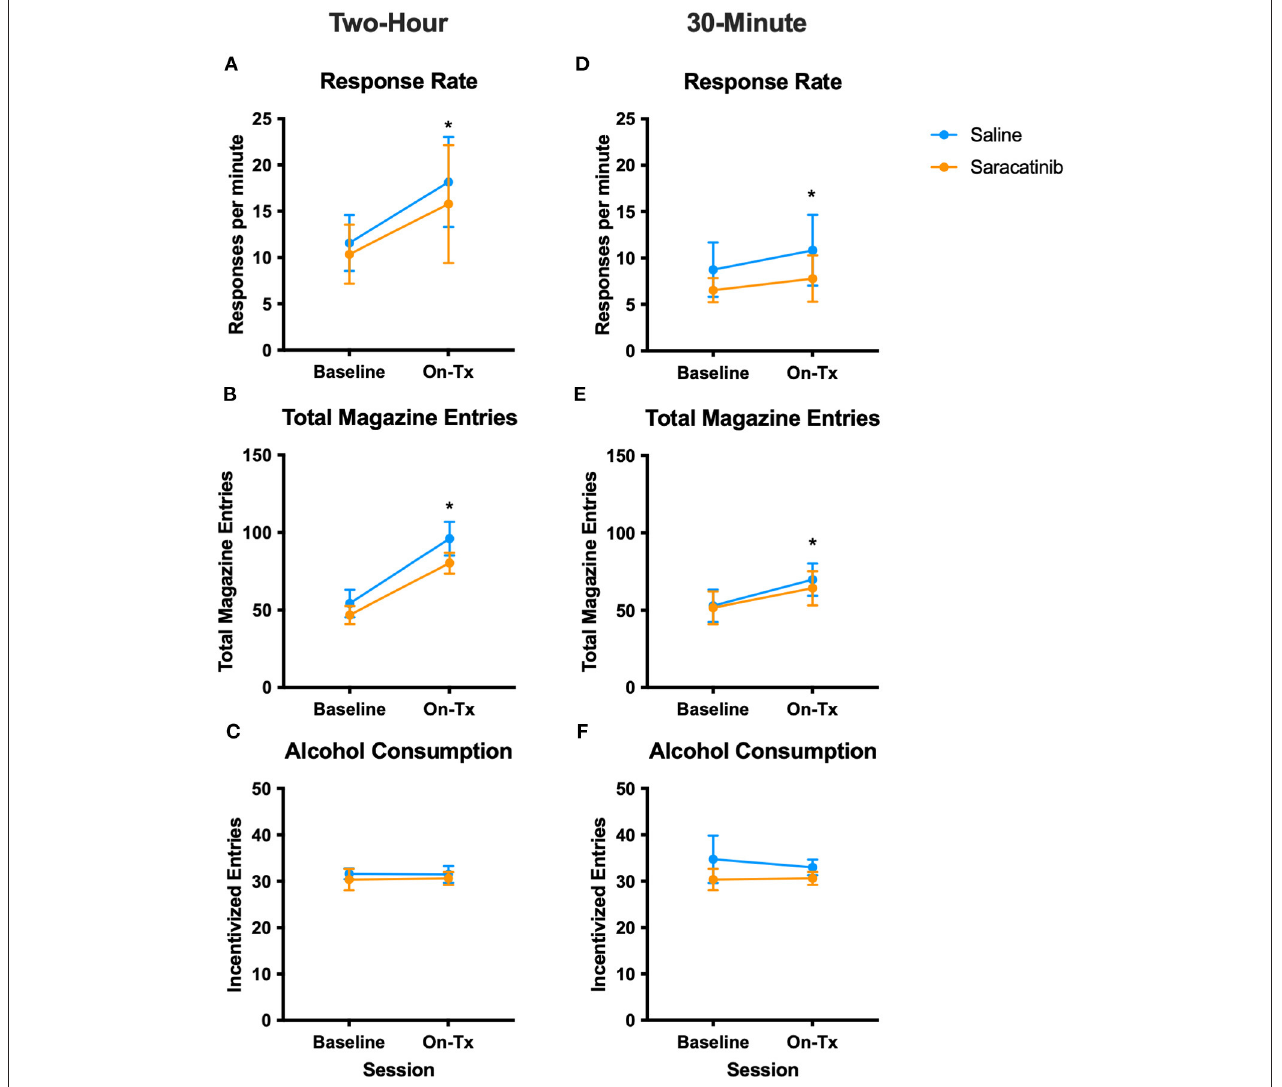
FIGURE 1 | 5 mg/kg saracatinib did not affect habitual ethanol-seeking or consumption in mice at either time point. Mice received an i.p. injection of saline 2h (A–C) or 30min (D–F) prior to the VI-60 session preceding contingency degradation (“Baseline”). The following day, mice received an i.p. injection of saline (control condition) or saracatinib 2h (A–C) or 30min (D–F) prior to the contingency degradation session (“On-Tx”). (A–C) Response rate, total magazine entries, and incentivized magazine entries for the 2-h time point, respectively. (D–F) Response rate, total magazine entries, and incentivized magazine entries for the 30-min time point. Two-hour time point: n = 8/drug. Thirty-minute time point: n = 8/drug. * p < 0.05 vs. baseline day across groups (main effect of session). Tx, treatment; i.p.,